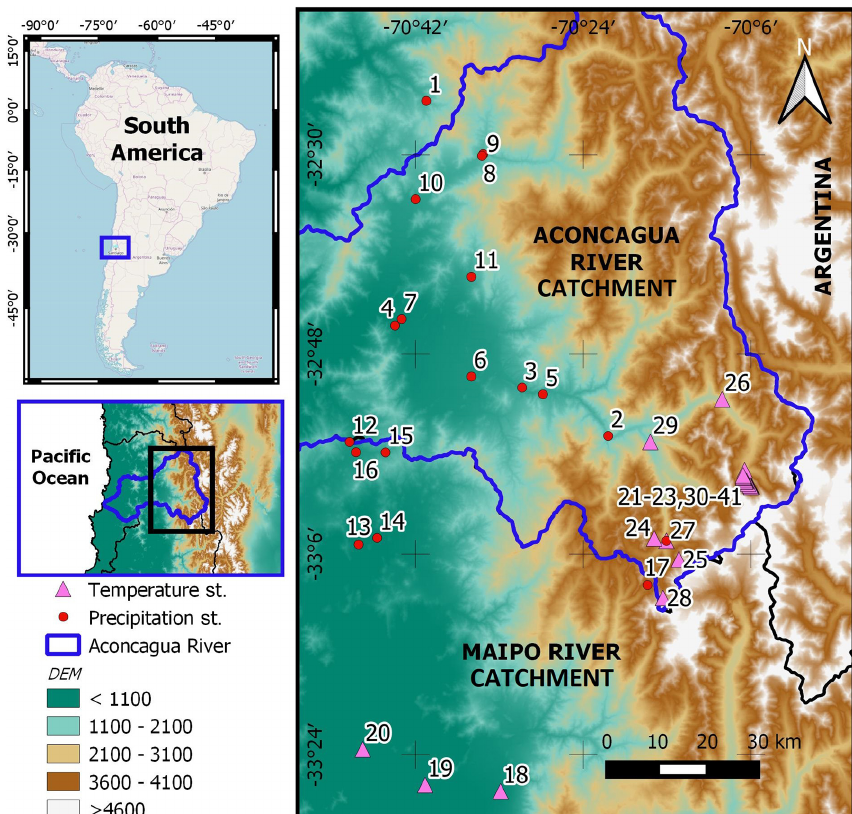
Figure 1. Temperature and precipitation gauges in the catchment with available data during the period of analysis. Further details of the gauges are provided in Appendix A. Upper left panel contributed by © OpenStreetMap contributors 2019. Distributed under a Creative Commons BY-SA